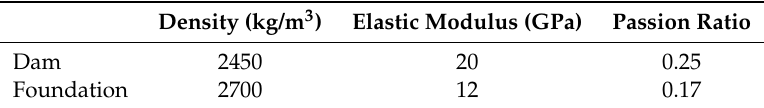
Table 4. Material properties of the system.